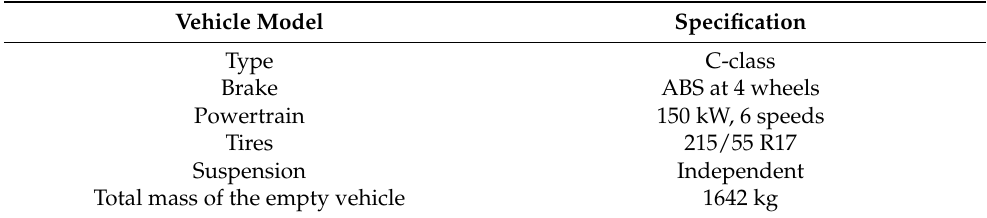
Table 1. Simulation vehicle